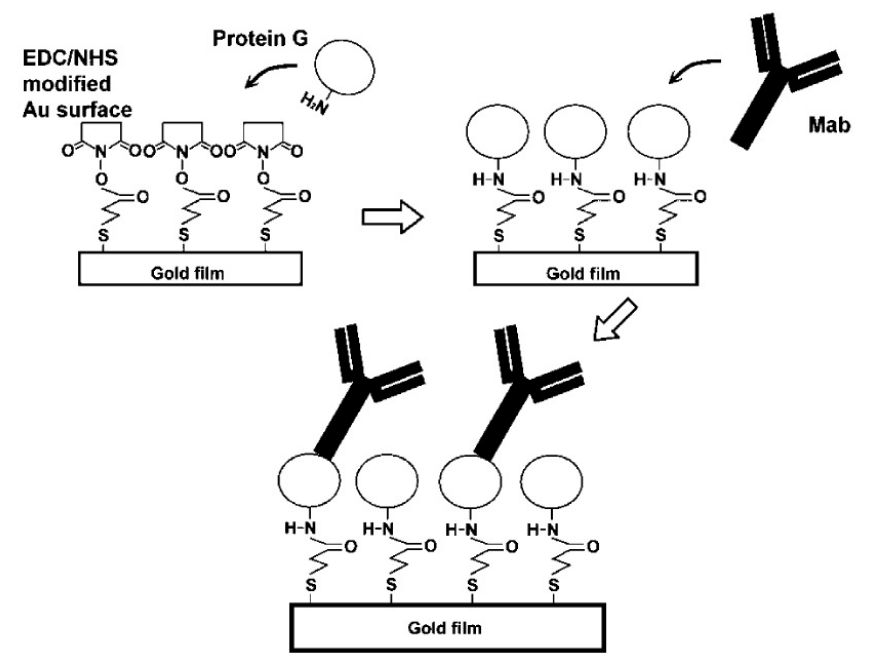
Figure 2. Schematic illustration of procedure adopted for immobilizing antibody on protein G layer (reproduced from reference [58]).